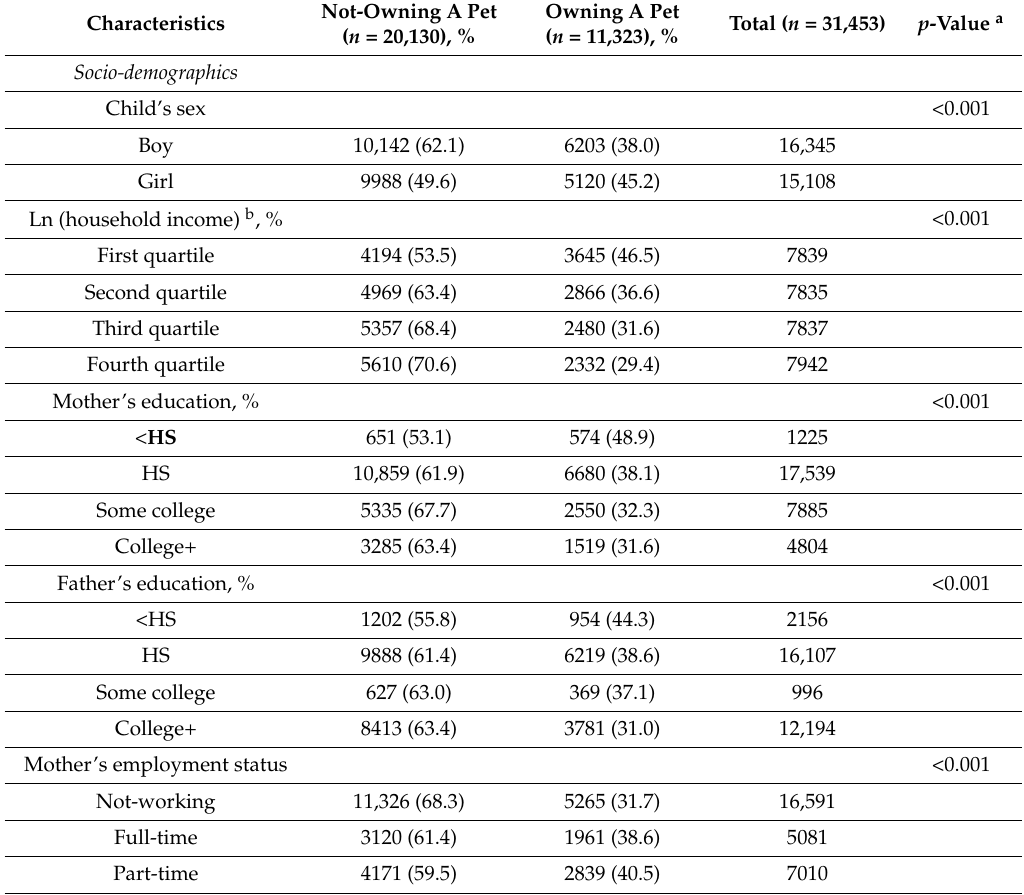
Table 2. Socio-demographic characteristics of children by their pet ownership